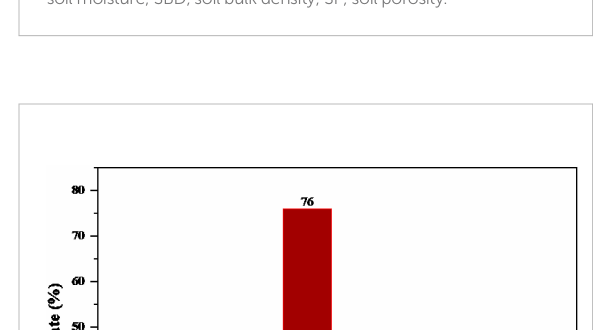
FIGURE 10 Redundancyanalysis between soil environmental factors and morphological characteristics of fi rst- and second-order fi ne roots. 1 and 2 represent fi rst- and second-orderroots, respectively; SRL, speci fi c rootlength; SRA, speci fi c surfacearea; D, diameter;RTD, roottissue density; AN, alkaline nitrogen; AP, availablephosphorus; OC, organic carbon; TN, total nitrogen; ST, soil temperature; SW, soil moisture; SBD,soil bulkdensity; SP, soil porosity.